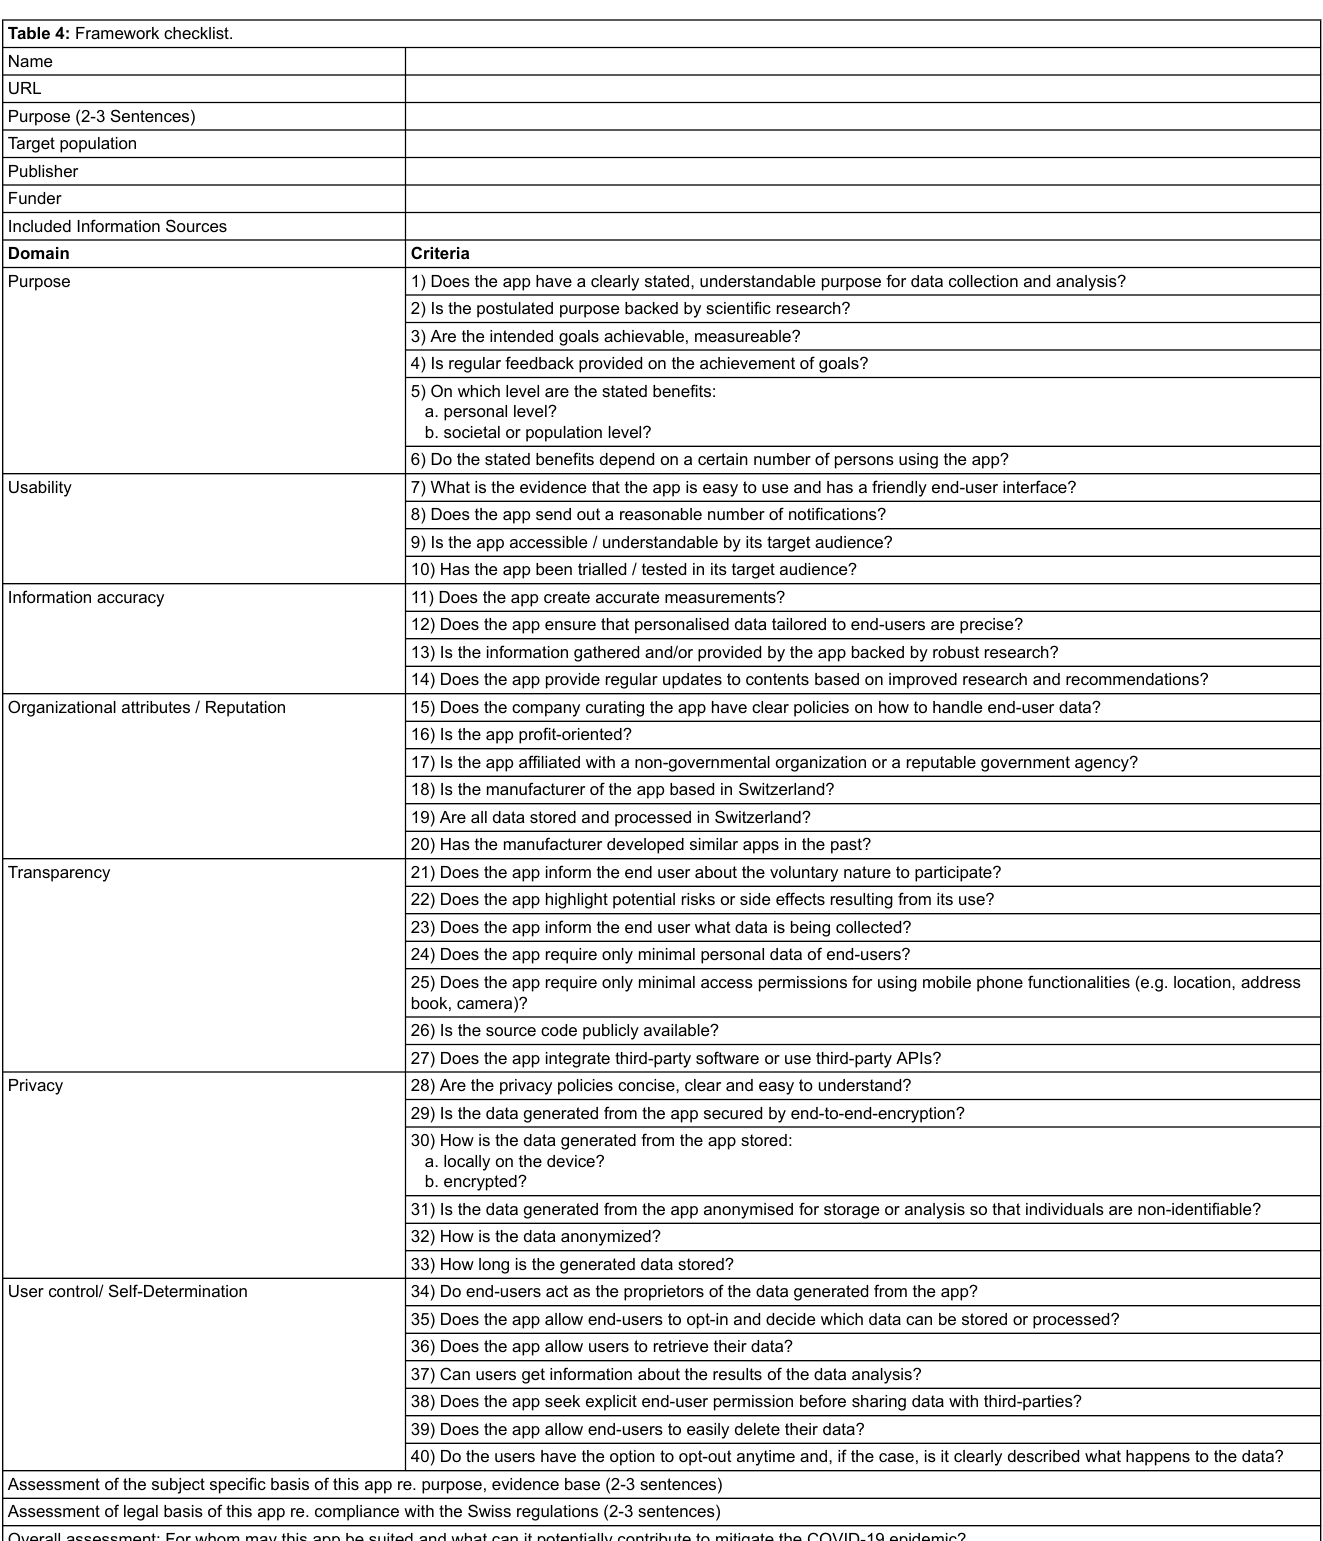
Table 4: Framework